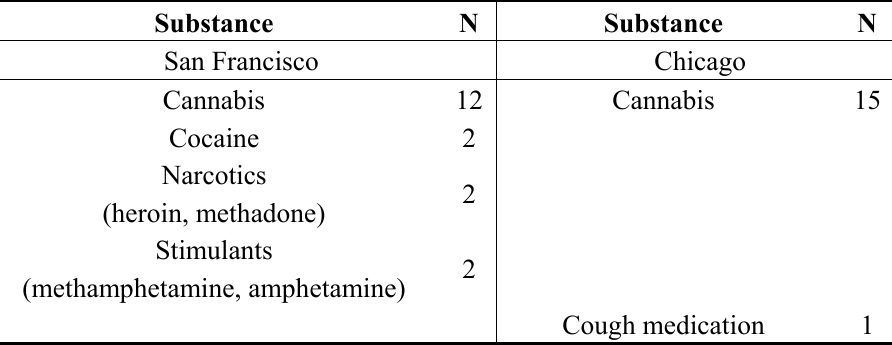
Table 4. Most frequent substances used